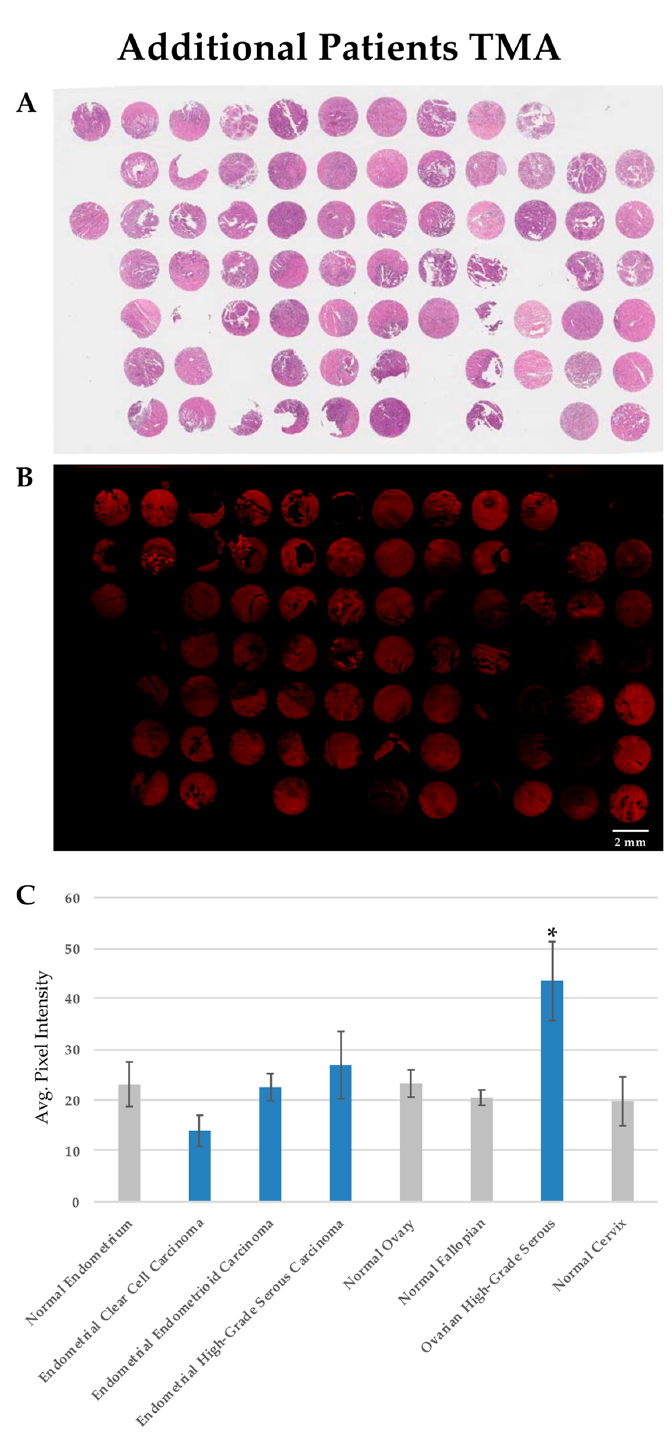
Figure 3. SBK4-TR staining of patient gynecologic cancer tissue section TMAs. Staining of adjacent TMAs with hematoxylin and eosin ( A ), and SBK4-TR ( B ). SBK4-TR staining shows various levels of staining intensity ( B ). Scale bar = 2 mm. The mean SBK4-TR staining intensity is significantly higher in high grade serous ovarian cancer compared with normal fallopian tube (* p = 0.012) or normal ovary (* p = 0.028). The other cancer types are similar to the controls ( C ). Mean and standard error (SE) are shown for the indicated tissue types.